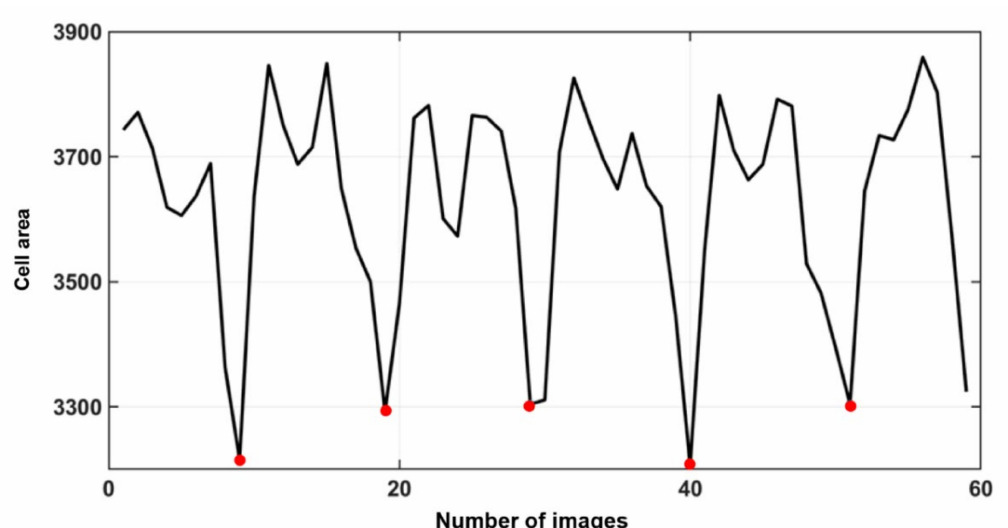
Figure 11. A smooth area change curve obtained based on data selected from the last 59 frames, which were then convolved and denoised.